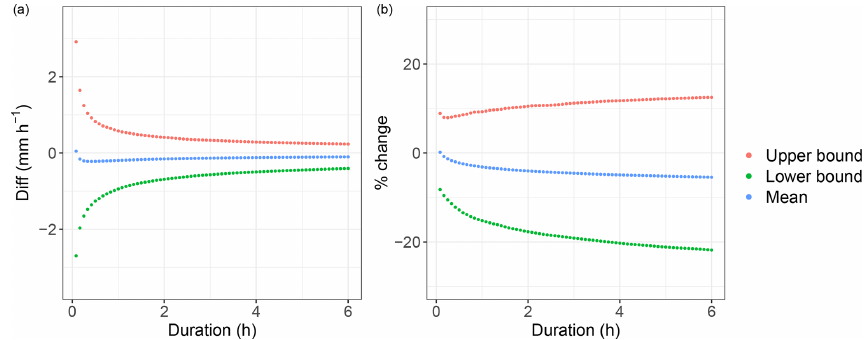
Figure 13. (a) Difference between the MC intensities (upper bound, lower bound and mean) and the reference threshold ones as a function of the duration; (b) percentage change of the MC intensities with respect to the reference threshold ones, as a function of the